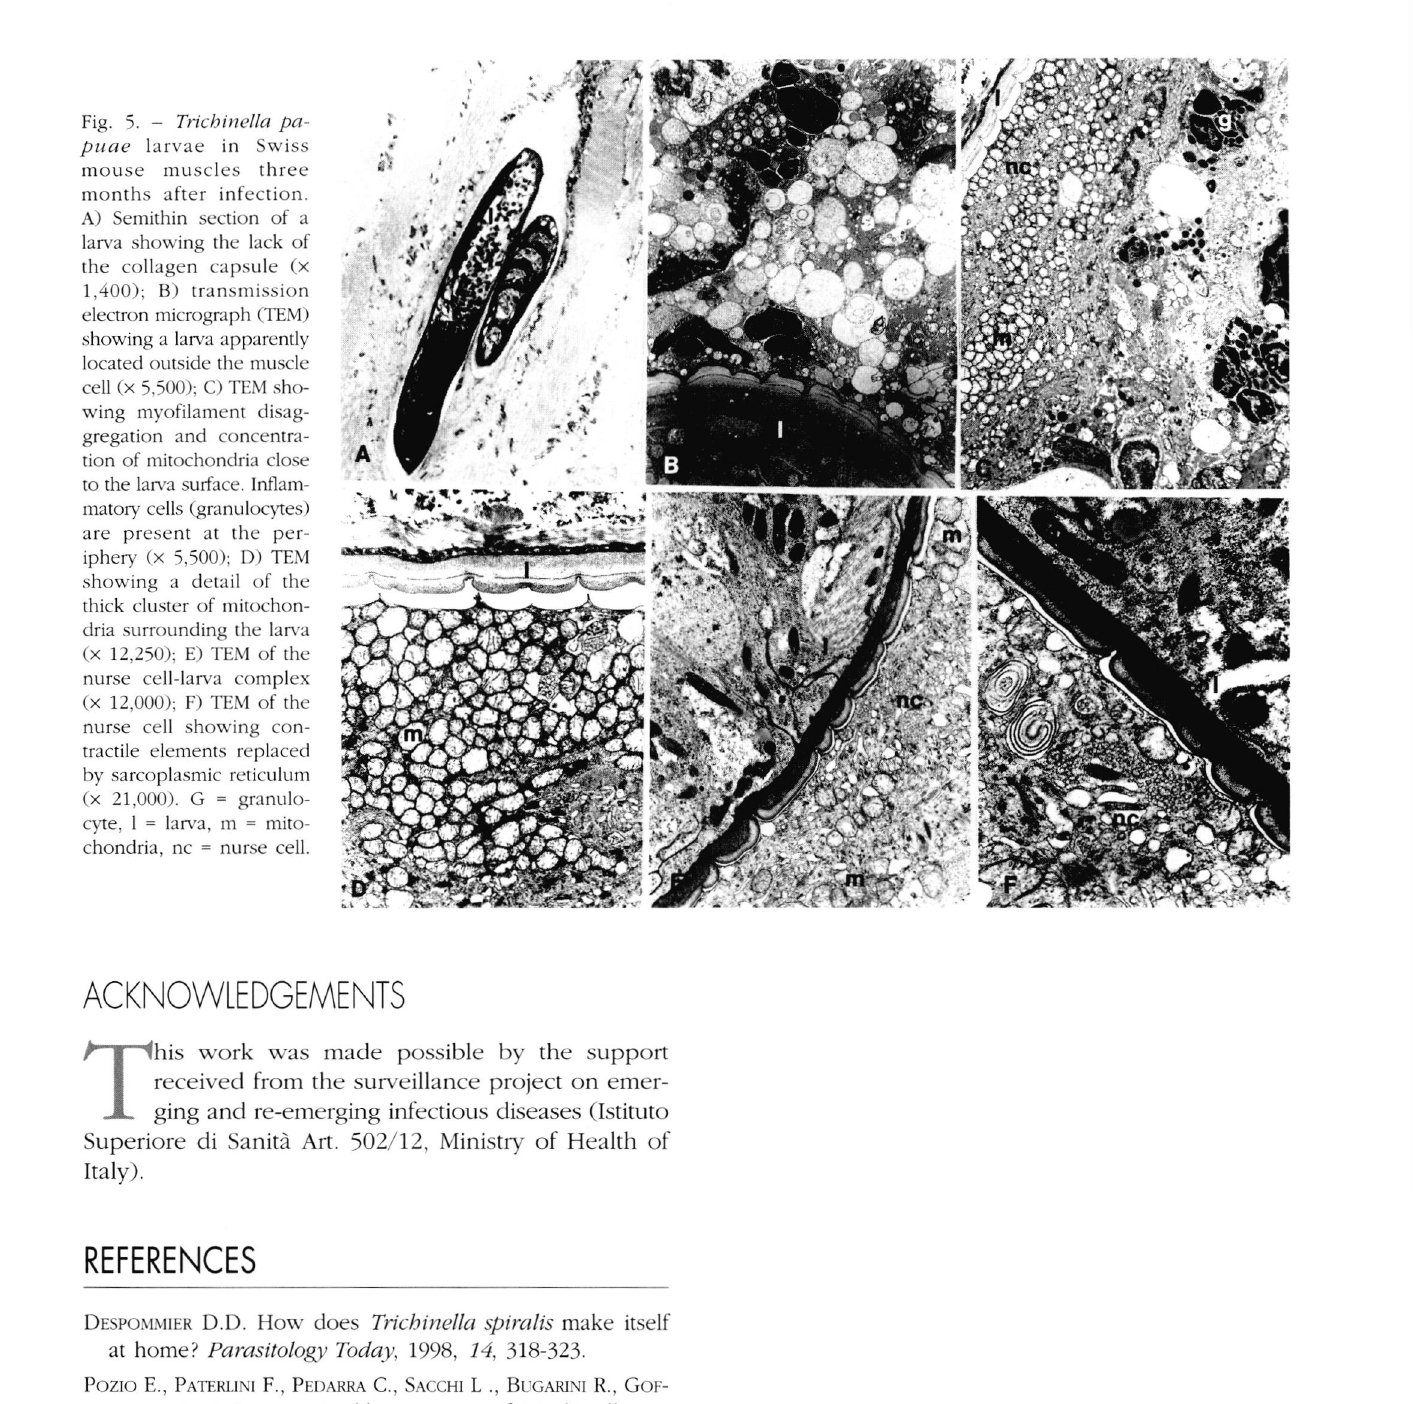
Fig. 5. - Trichinella pa- puae larvae in Swiss mouse muscles three months after infection. A) Semithin section of a larva showing the lack of the collagen capsule (x 1,400); B) transmission electron micrograph (TEM) showing a larva apparently located outside the muscle cell (X 5,500); C) TEM sho­ wing myofilament disag­ gregation and concentra­ tion of mitochondria close to the larva surface. Inflam­ matory cells (granulocytes) are present at the per­ iphery (x 5,500); D) TEM showing a detail of the thick cluster of mitochon­ dria surrounding the larva (X 12,250); E) TEM of the nurse cell-larva complex (x 12,000); F) TEM of the nurse cell showing con­ tractile elements replaced by sarcoplasmic reticulum (x 21,000). G = granulo­ cyte. 1 = larva, m = mito­ chondria, nc = nurse